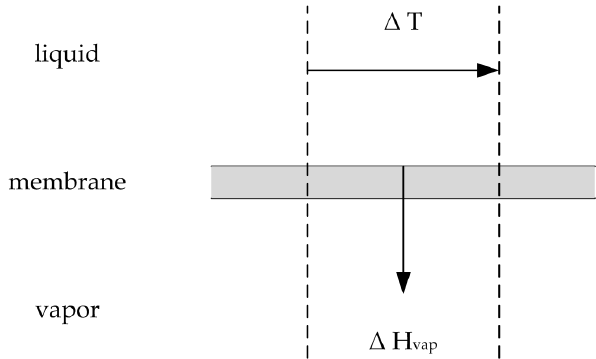
Figure 3. Illustration of the heat transfer via vaporization. Adapted from [21].